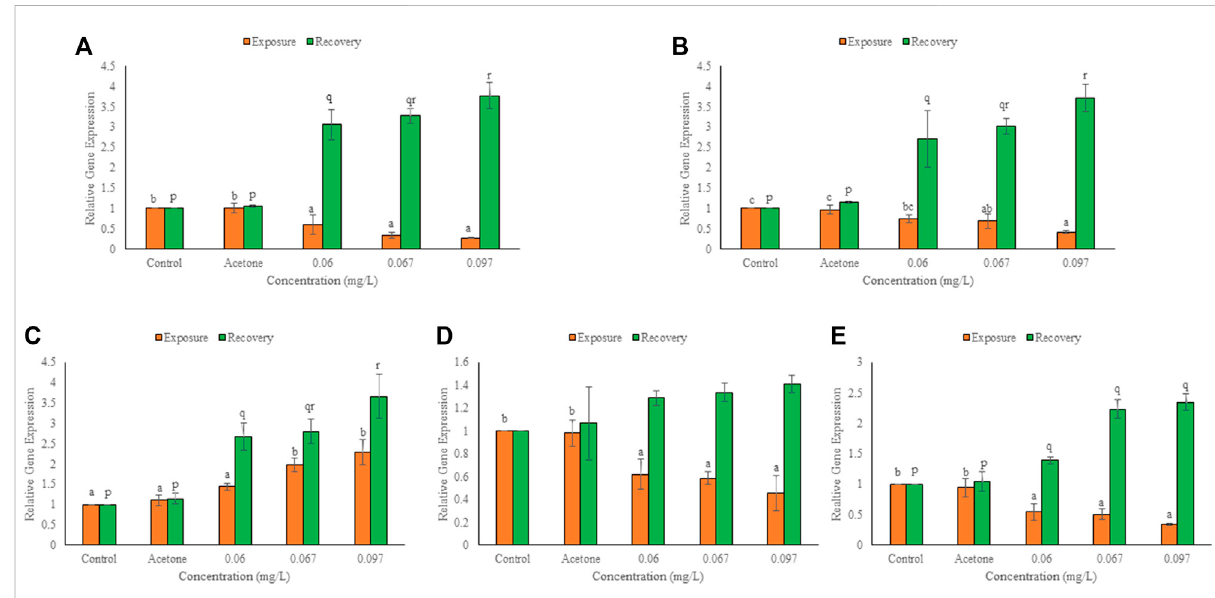
FIGURE 5 Expression ofDHPR (A) , myosin lightpolypeptide 3 (B) , α -tropomyosin (C) ,desminb (D) ,laminb1 (E) inthehatchlings of L.rohita after 96 hand 10 dayspost exposureto TCS.Values are, mean ± SD, n = 3, different alphabets represent signi fi cant ( p ≤ 0.01) differencewithin thetreatments after 96 h (a-c) and after 10 days of recovery period